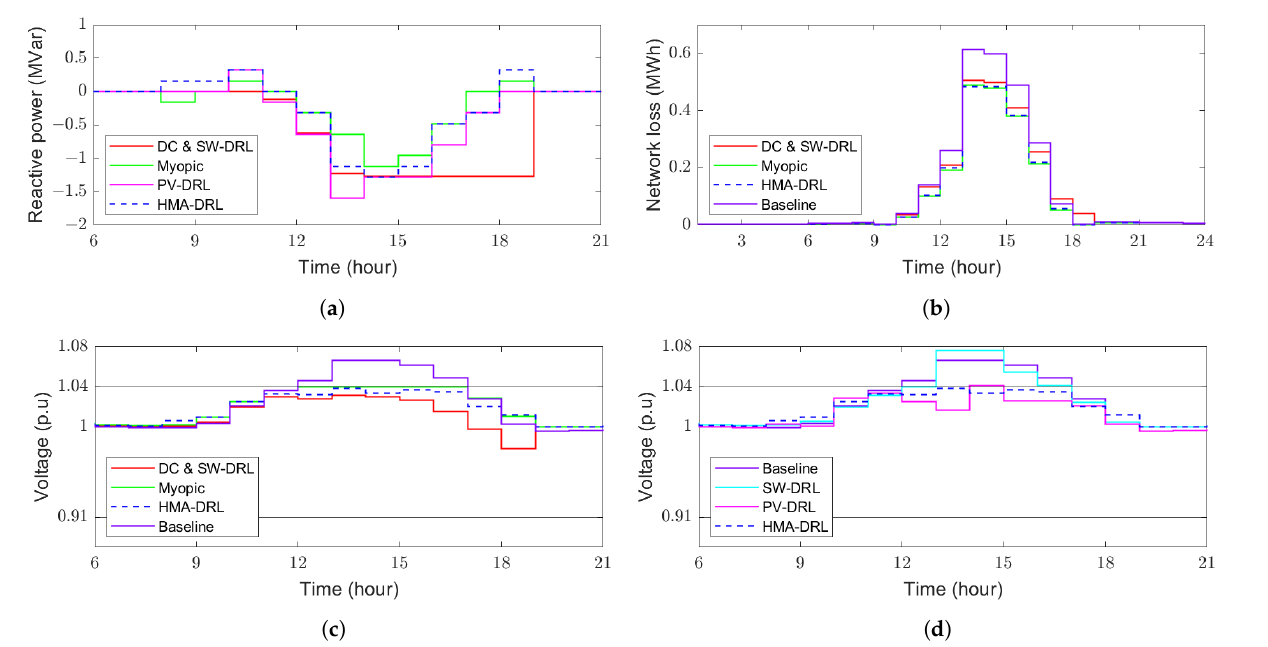
Figure 7. The action of agent at PVSI and CCC on the first day. ( a ) Reactive power of smart inverter at bus 18; ( b ) comparison of network power loss; ( c ) voltage profile comparison 1 at bus 18; ( d ) voltage profile comparison 2 at bus 18 (DRL-based algorithms).